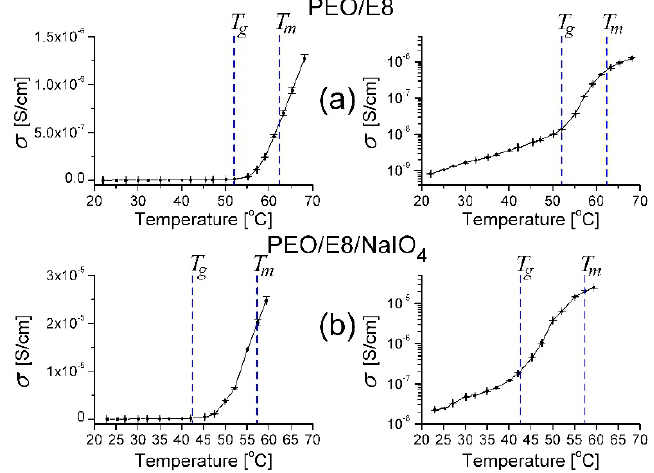
Figure 6. Nyquist plots of PEO/E8 ( a ) and PEO/E8/NaIO 4 ( b ) at various temperatures. The arrows show the effect of increasing temperature. Inserts: the Nyquist plots that correspond to impedances measured at the glass-transition temperature ( T g ) for both composites.